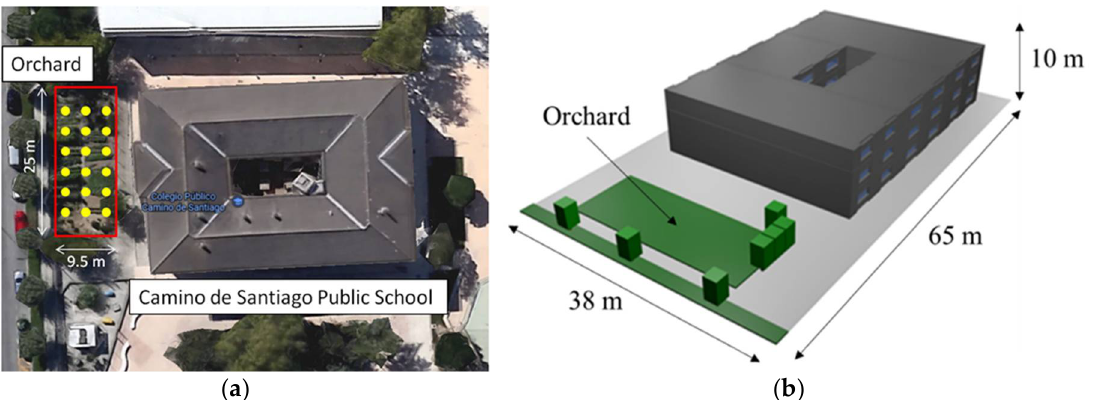
Figure 1. ( a ) ‘Camino de Santiago’ public school’s upper view; ( b ) View of the created scenario for the 3D Ray Launching